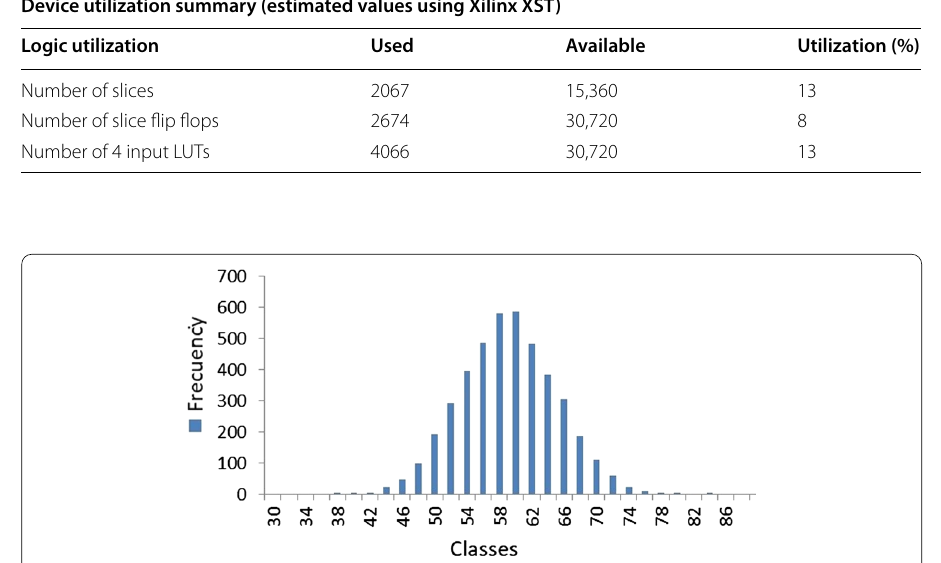
Table 1 Hardware resources for RO PUF implemented on Virtex 4 Device utilization summary (estimated values using Xilinx XST)